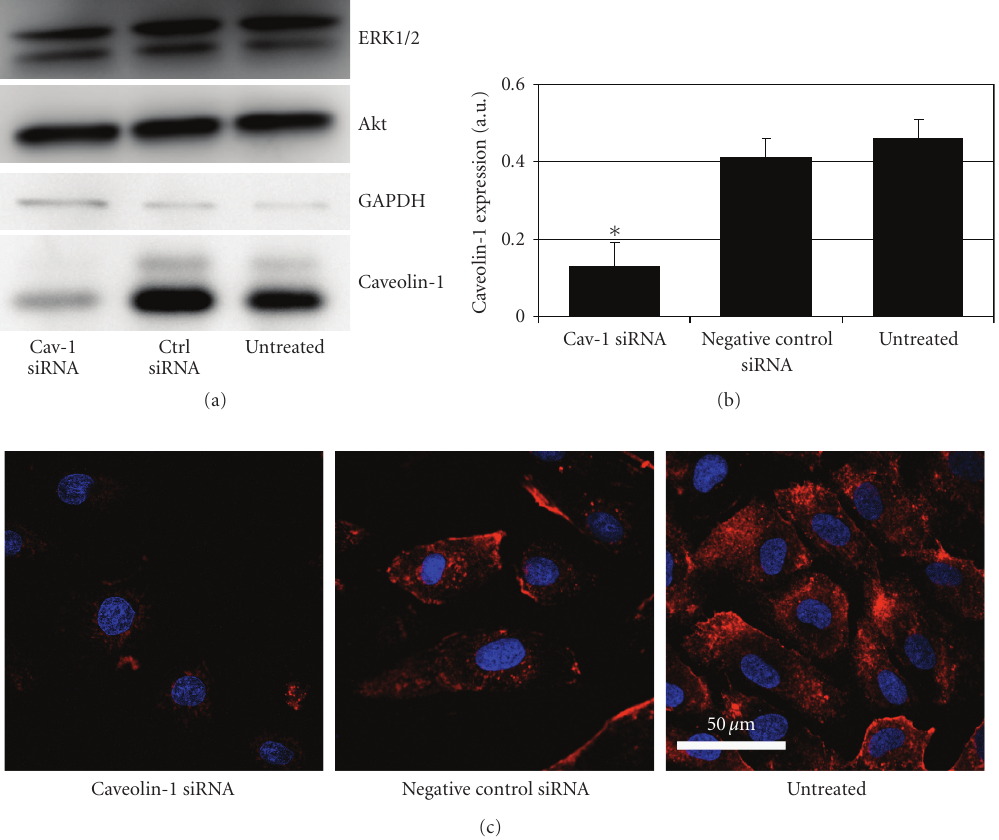
Figure 2: Downregulation of caveolin-1 expression by RNAi. HUVECs were treated with caveolin-1 siRNA, negative control siRNA, or left untreated. Caveolin-1 levels were determined 48 hours after transfection. (a) Immunoblot analysis of cell lysates. Equal loading of proteins of each transfection condition was ensured by detecting the unrelated metabolic enzyme GAPDH on the same blot. (b) Quantification of the signal intensities in the immunoblot assay. The bars represent average intensities of the caveolin-1 band in seven separate experiments. Error bars represent standard deviation. Caveolin-1 siRNA treated cells had significantly lower caveolin-1 expression than control siRNA-treated cells ( ∗ P < . 0001, Student’s t -test). No significant di ff erences were found between untreated cells and negative control siRNA-treated cells. Bars represent averages of seven separate experiments. (c) Confocal microscopic imaging of caveolin-1. Treated cells were fixed and labeled with caveolin-1 antibodies that were detected by Alexa 633-coupled secondary antibodies. Nuclei were stained with DAPI. All images were taken with the same microscope settings. Scale bar is 50 μ